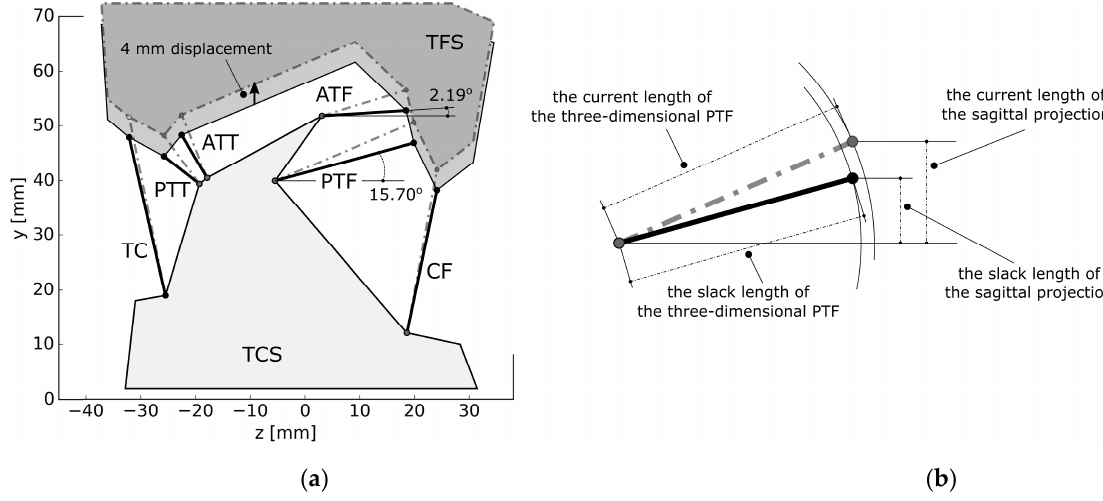
Figure 2. ( a ) The ligament system of the ankle as seen in the frontal plane in two configurations: initial and with the segments displaced by 4 mm along the y-axis; ( b ) PTF and its projection onto the sagittal plane in two configurations: initial and with the segments displaced by 4 mm along the y-axis.